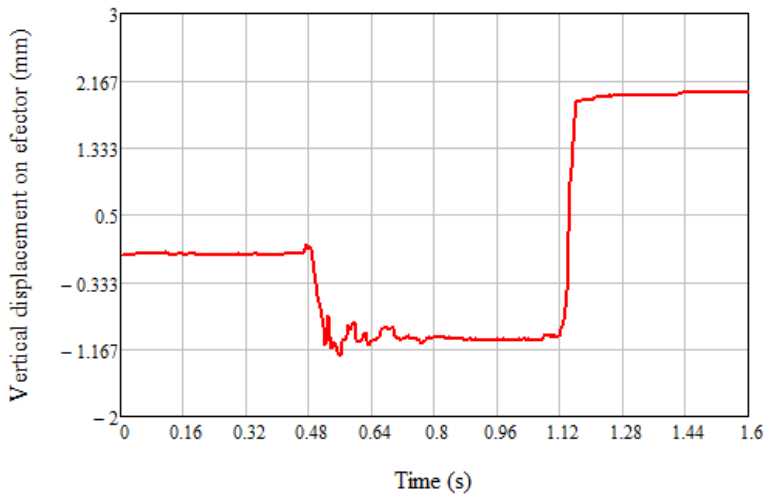
Figure 22. Vertical displacement variations for the 1.5 kg mass. The negative displacement is due to the operator who held the plate rod with one hand and applied the weight to the plate with the second hand. The final displacement (mediated in the interval (1.3, 1.4) s) was determined from the mean value in the time interval (0, 0.4) s, considered to be zero.